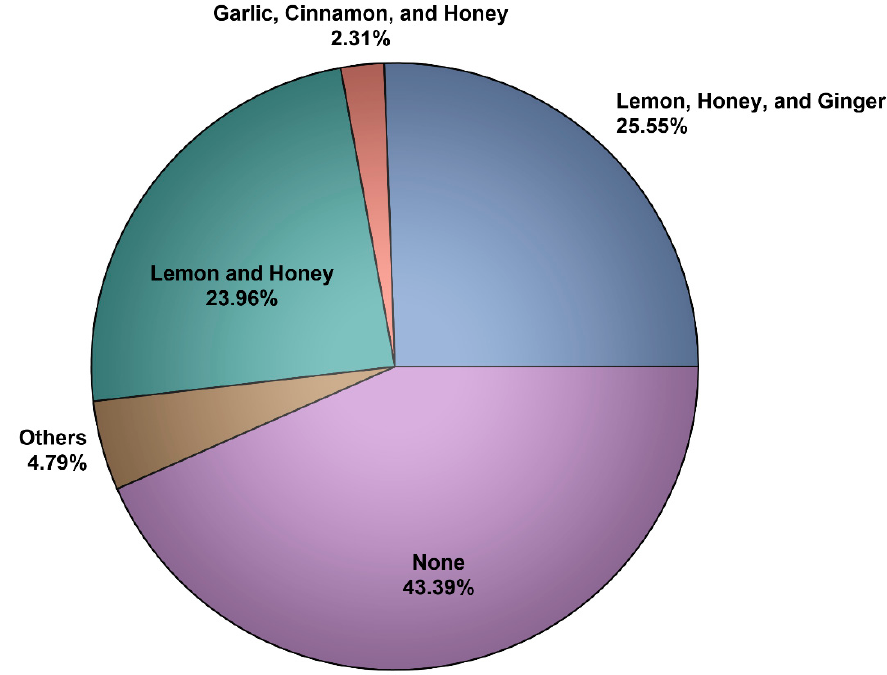
Figure 2. The most commonly utilized NP mixtures among NP users (n = 955).